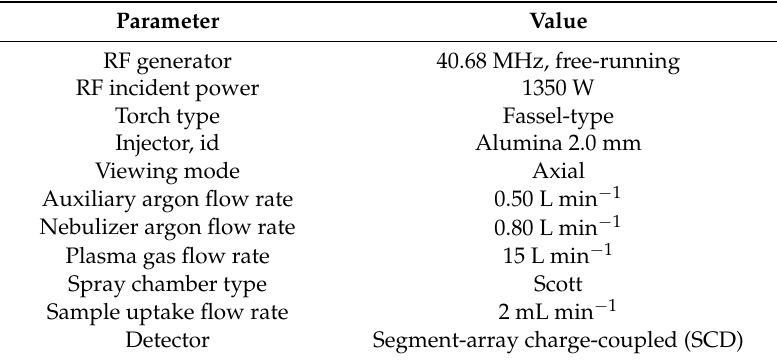
Table 1. Operating conditions and settings of the ICP-AES.